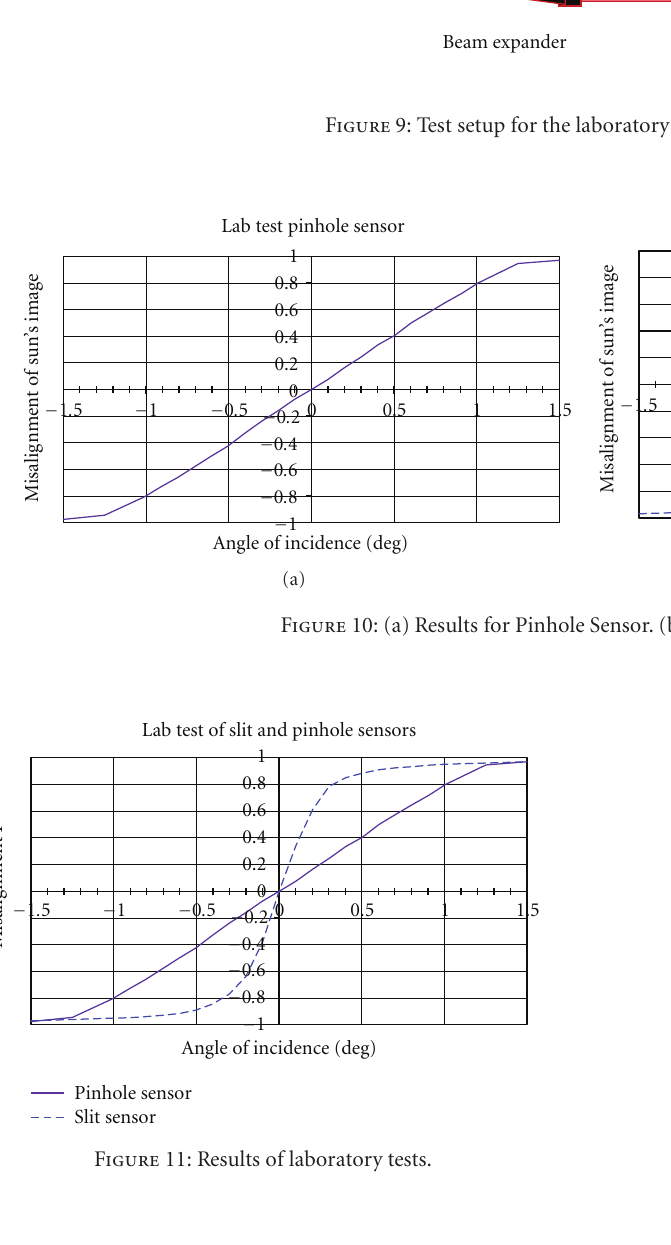
Figure 12: Scheme of field tests of the